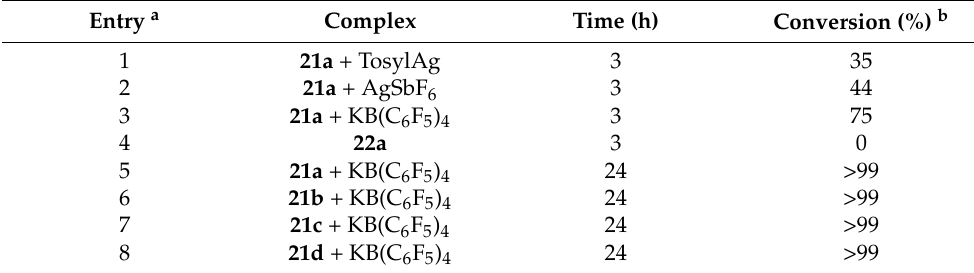
Table 5. Hydroamination of phenylacetylene with aniline.